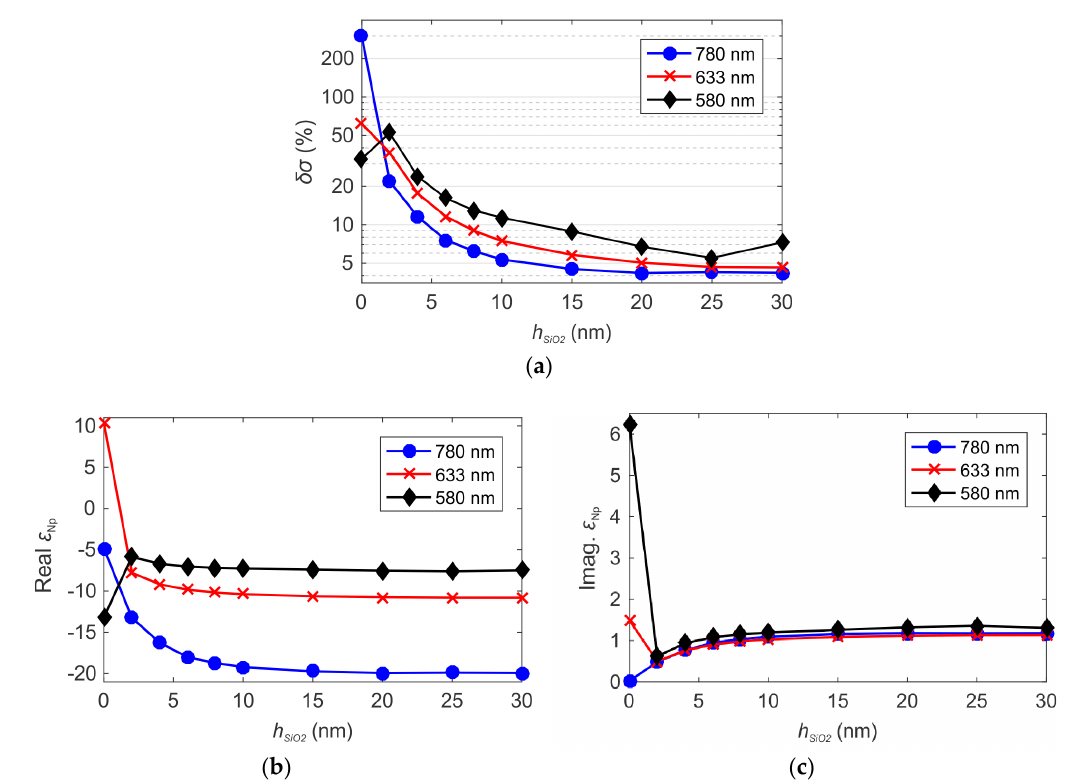
Figure 13. ( a ) Relative percentage deviation δσ between the real surface density σ FEM and the density σ MG calculated using the MG theory to fit the TM 0 resonance angle θ FEM . Real ( b ) and imaginary ( c ) parts of the dielectric constant of the AuNPs ( ε Np ) calculated by the MG theory in order to fit the exact reflectivity curves calculated by the FEM method. The results are shown in function of h SiO2 and for the excitation wavelengths of 580 nm, 633 nm and 780 nm. Fixed parameters: h Au = 46 nm, 2 a = 10 nm and σ ≈ 40 NP/µm 2 .